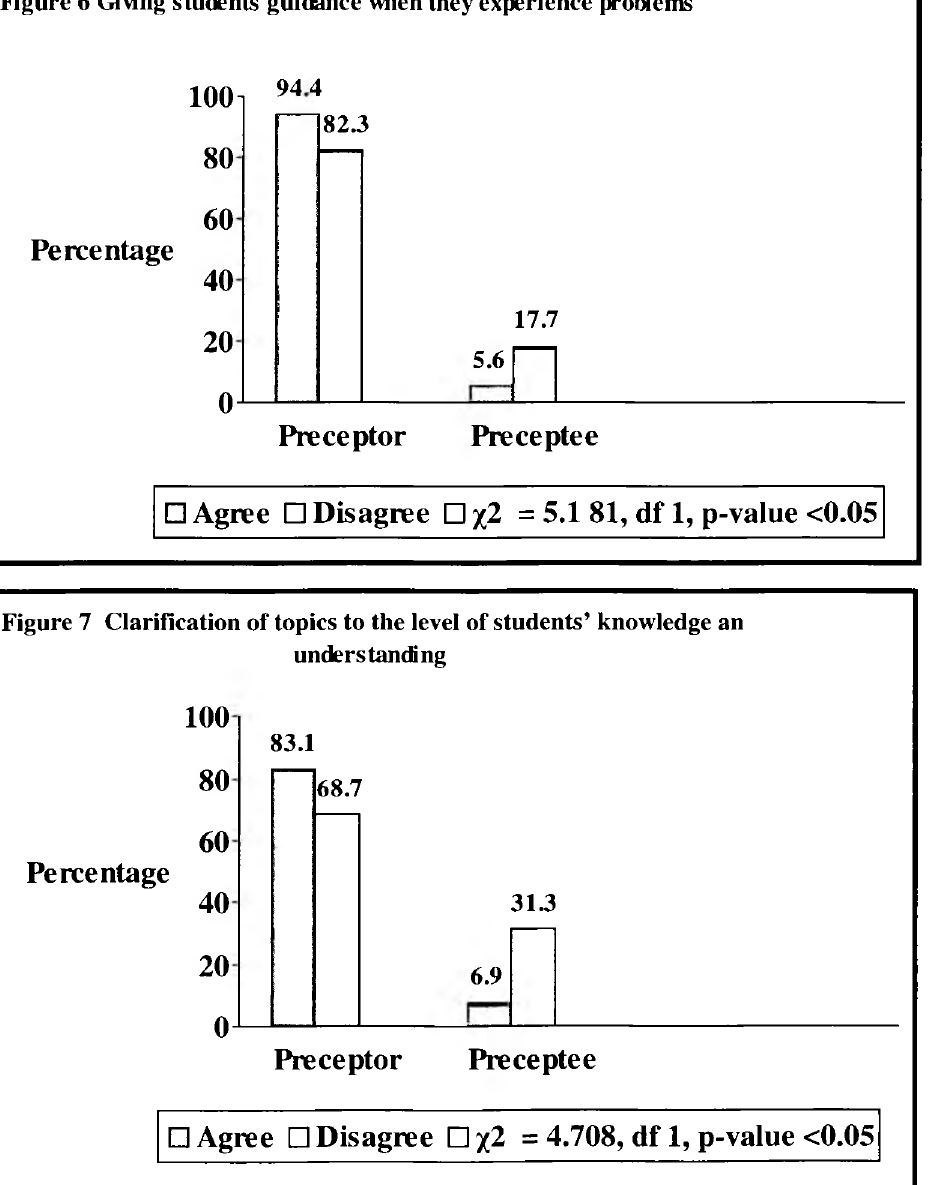
Figure 7 Clarification of topics to the level of students’ knowledge an